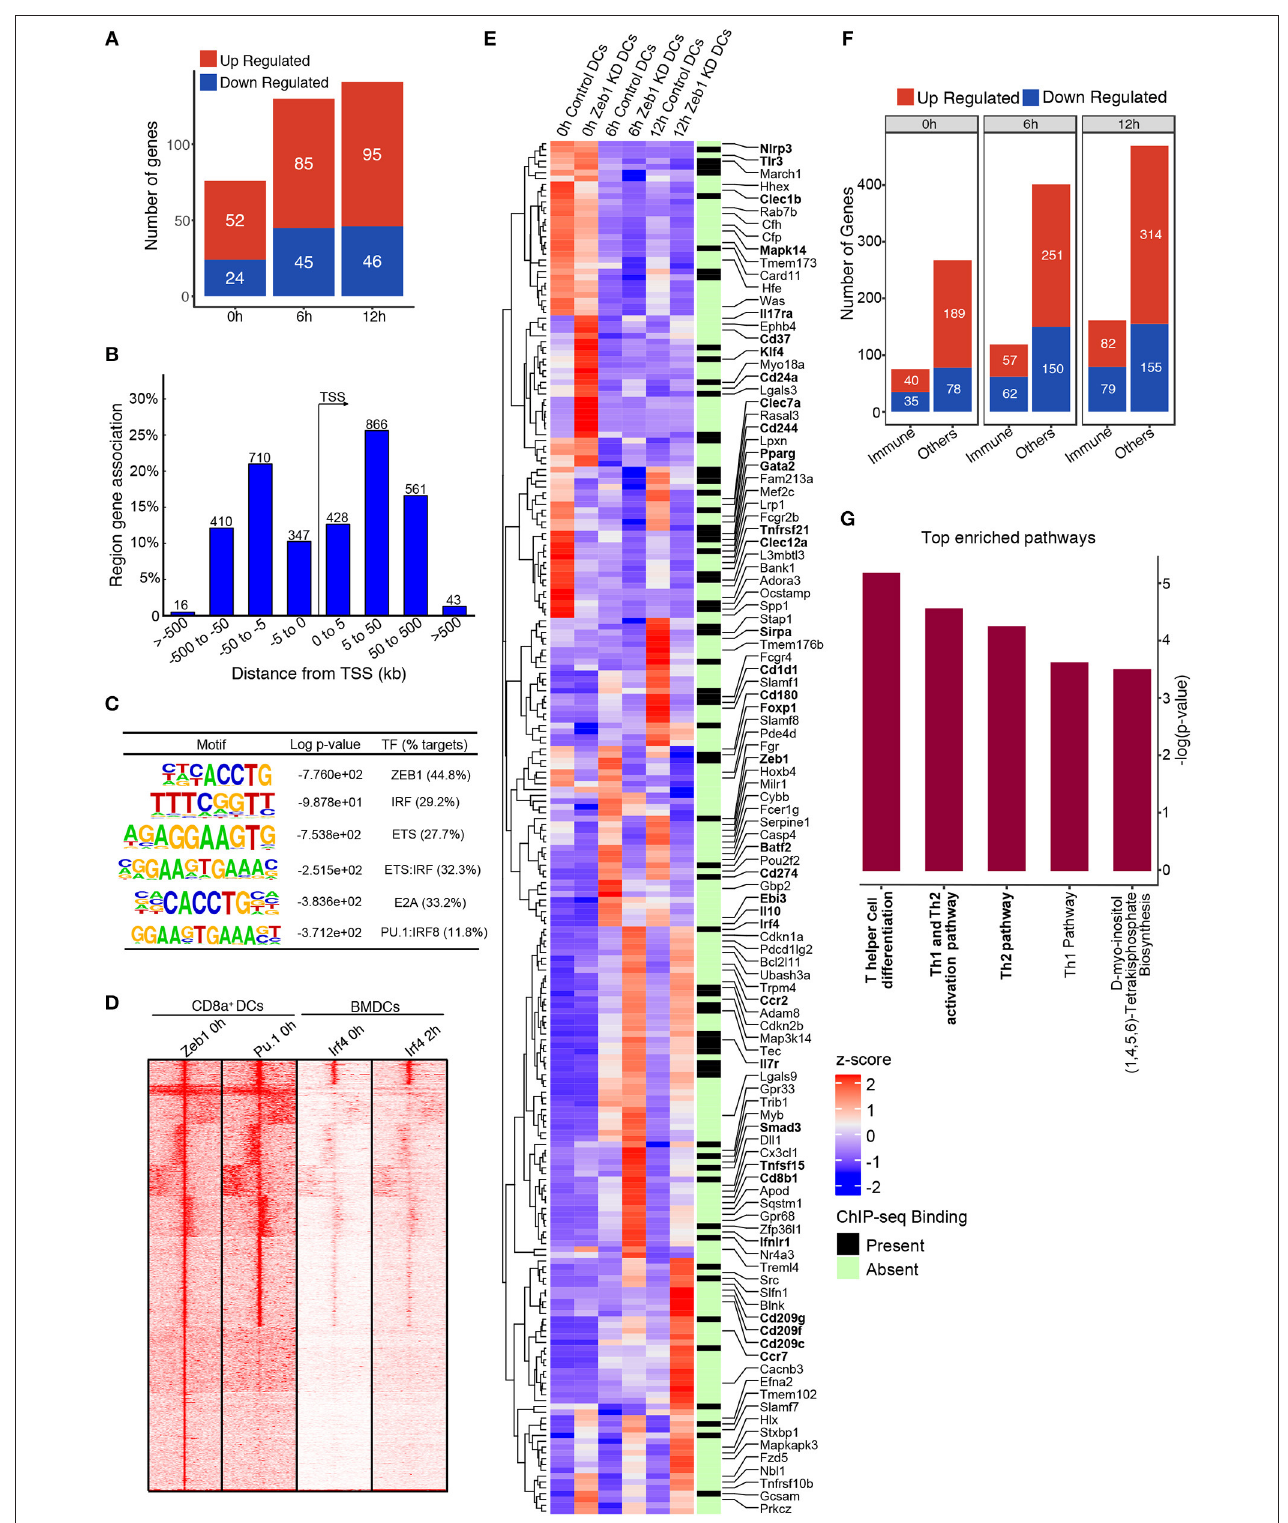
FIGURE 7 | Integrative genomic analysis using ChIP-seq and RNA-seq identified that Zeb1 does not act as global repressor of immune response genes. (A) Bar-plot depicting the genes that were directly regulated (upregulated and down-regulated) by Zeb1 KD at 0, 6, and 12h after CpG activation in cDC1 DCs. The direct target genes of Zeb1 were identified by correlating the gene list from Zeb1 KD RNA-seq and Zeb1 ChIP-seq binding analysis. (B) Genomic Regions Enrichment of